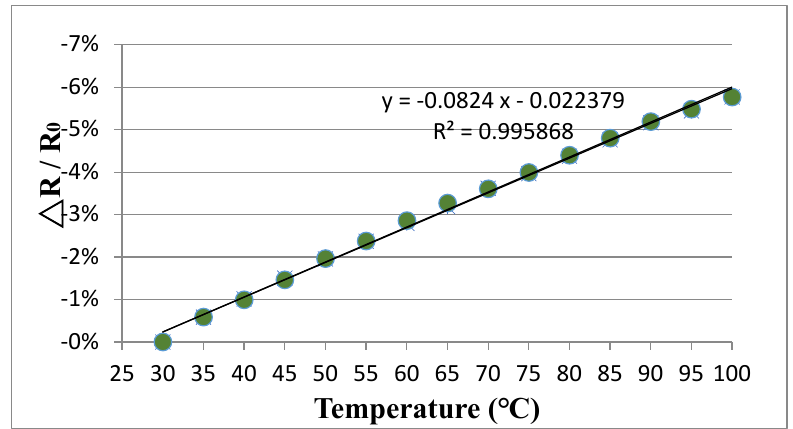
Figure 14. Relative resistance change vs. temperature change for the buckypaper made of high aspect ratio MWCNTs.